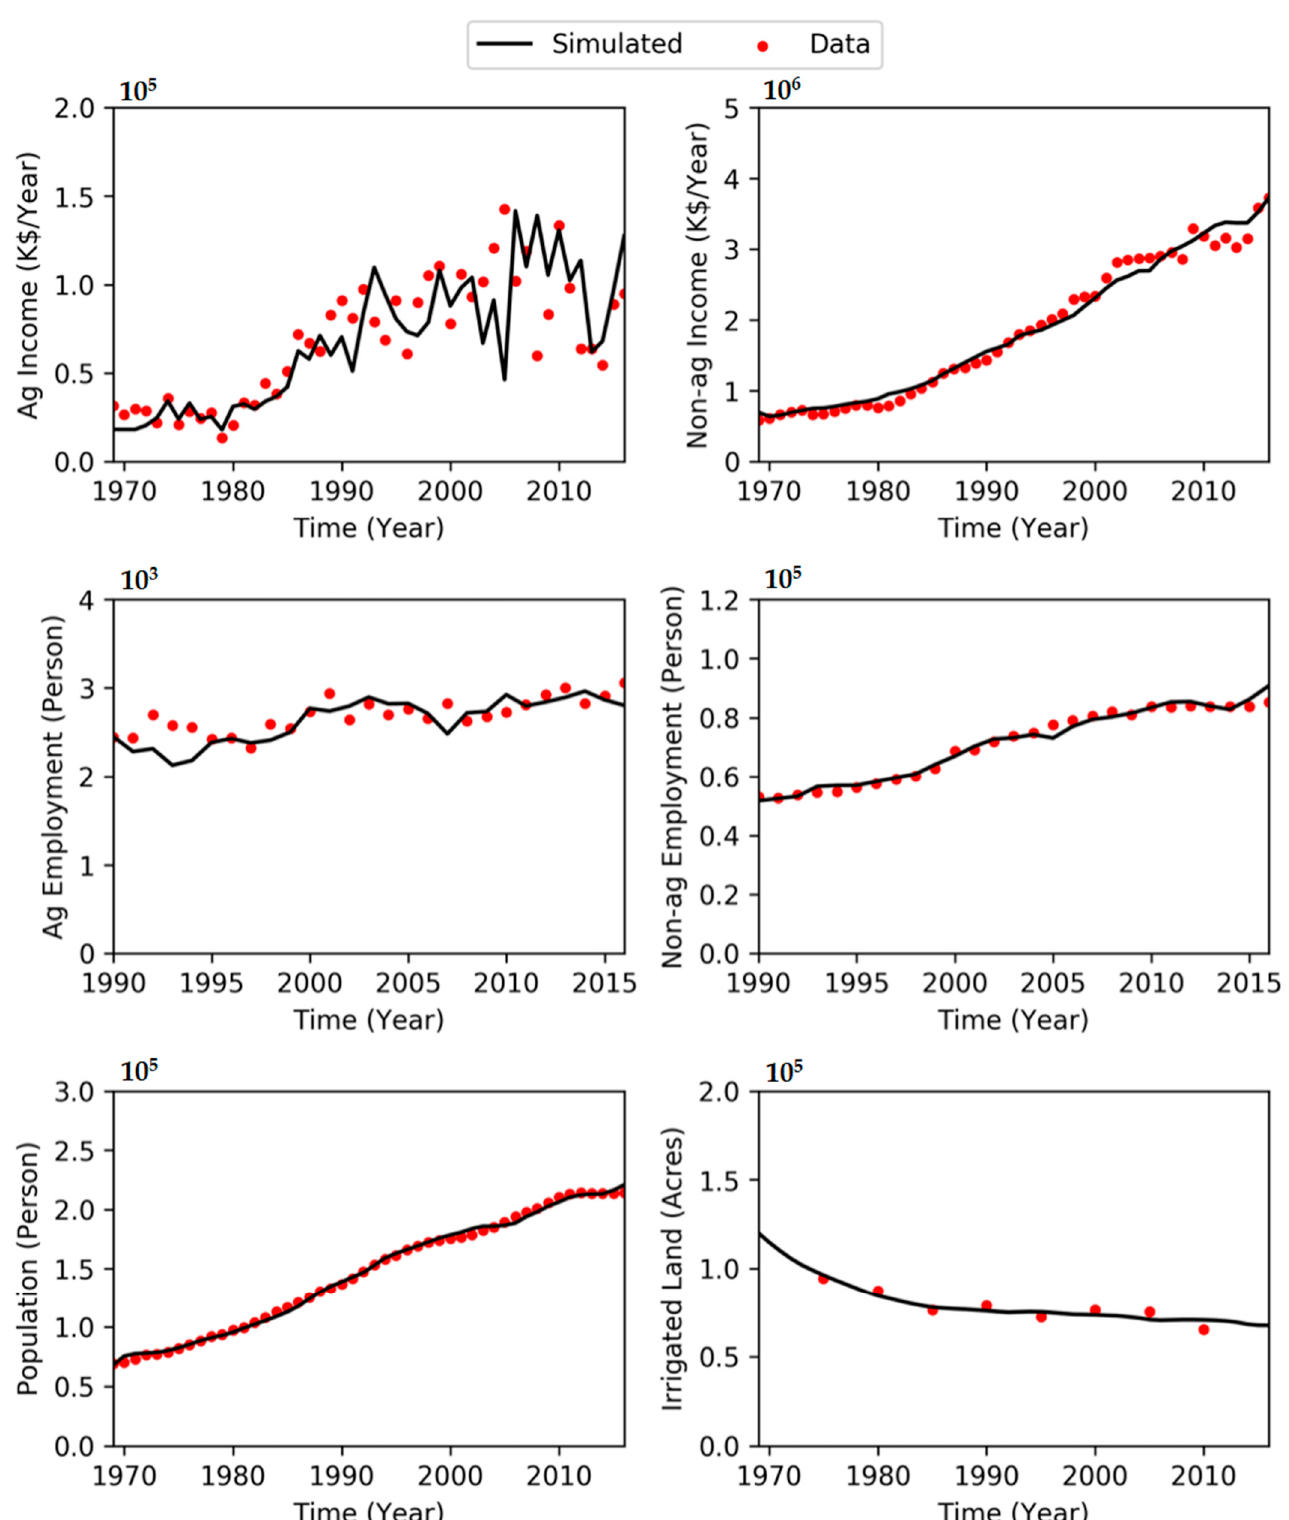
Figure A2. Behavior reproduction results (socioeconomic variables ).